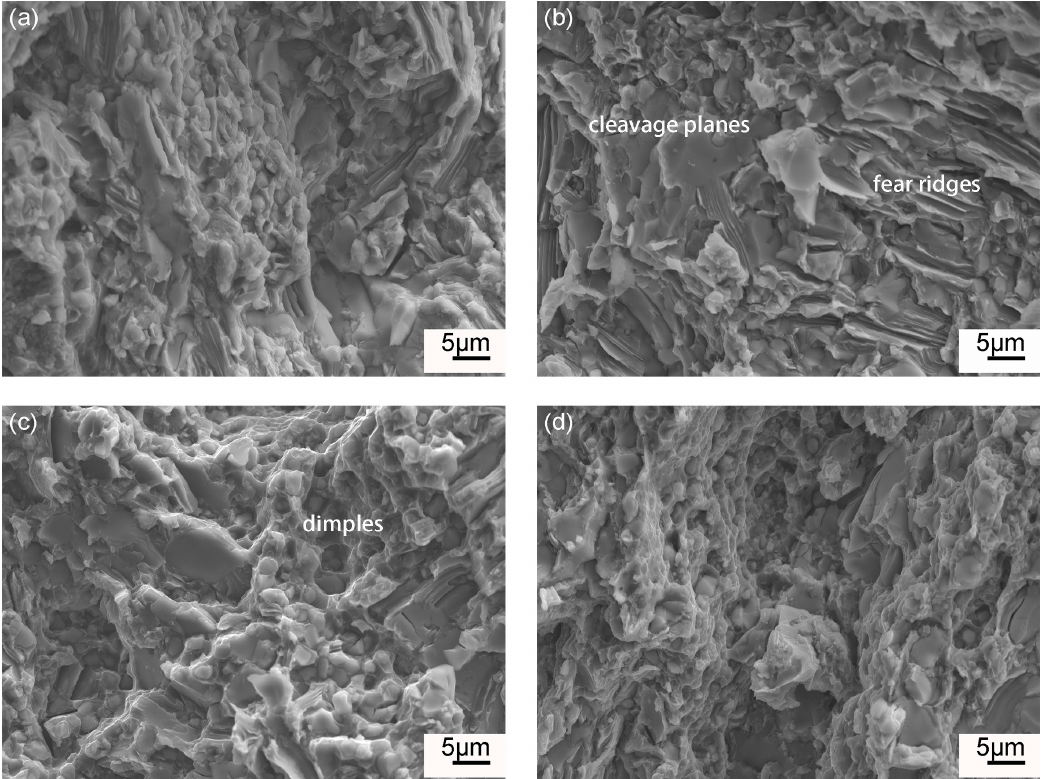
Figure 13. Tensile fracture morphologies of Mg-13Gd-4Y-2Zn-0.5Zr alloy after different passes: ( a ) 1 pass, ( b ) 2 passes, ( c ) 3 passes, ( d ) 4 passes.